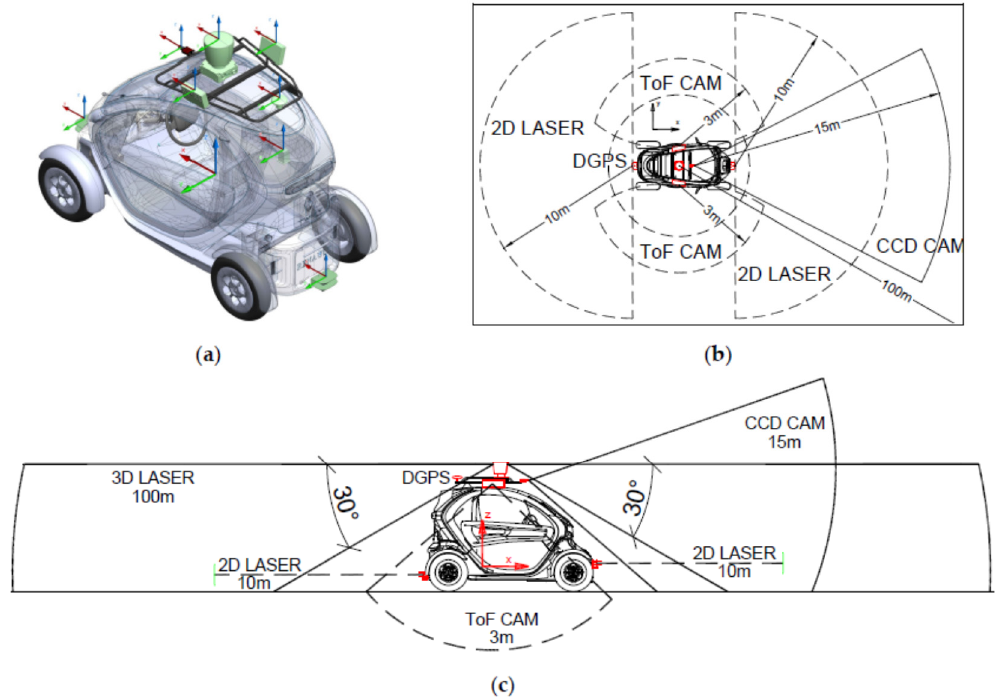
Figure 4. ( a ) CICar 3D model with reference frames; ( b , c ) plant and side views of the perception system ranges and